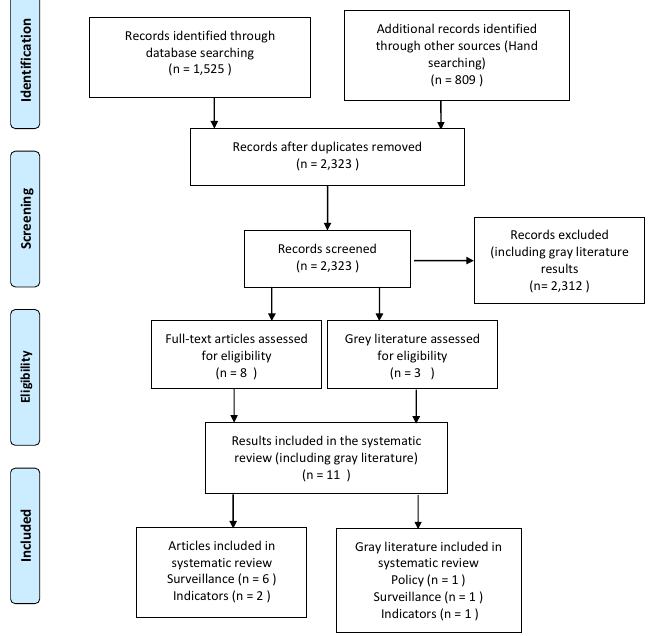
Figure 3. Prisma Flowchart of Review Results.